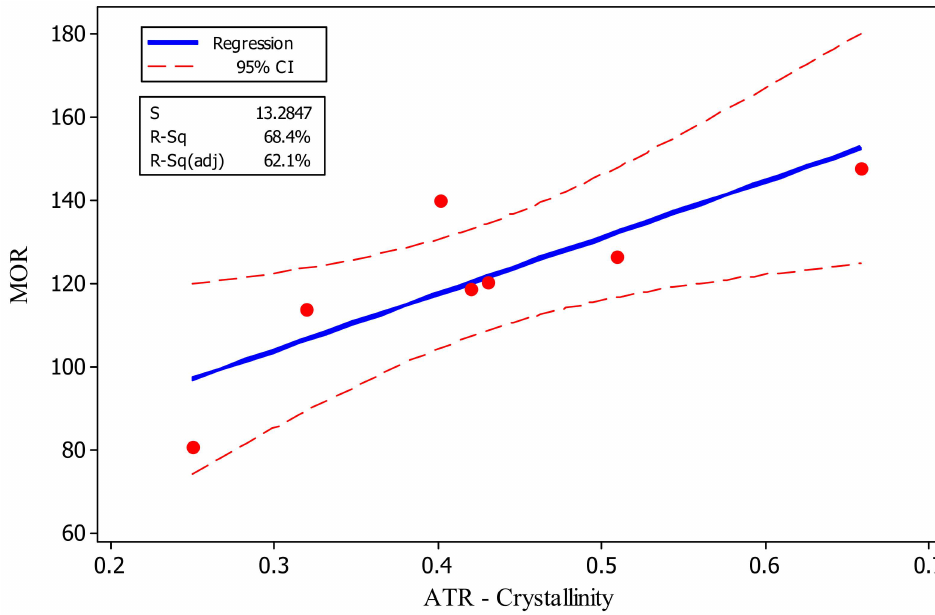
Figure 7. Fitted-line plot between Attenuated Total Reflectance (ATR)-crystallinity versus mechanical properties (MOR) in the seven treatments studied in the present